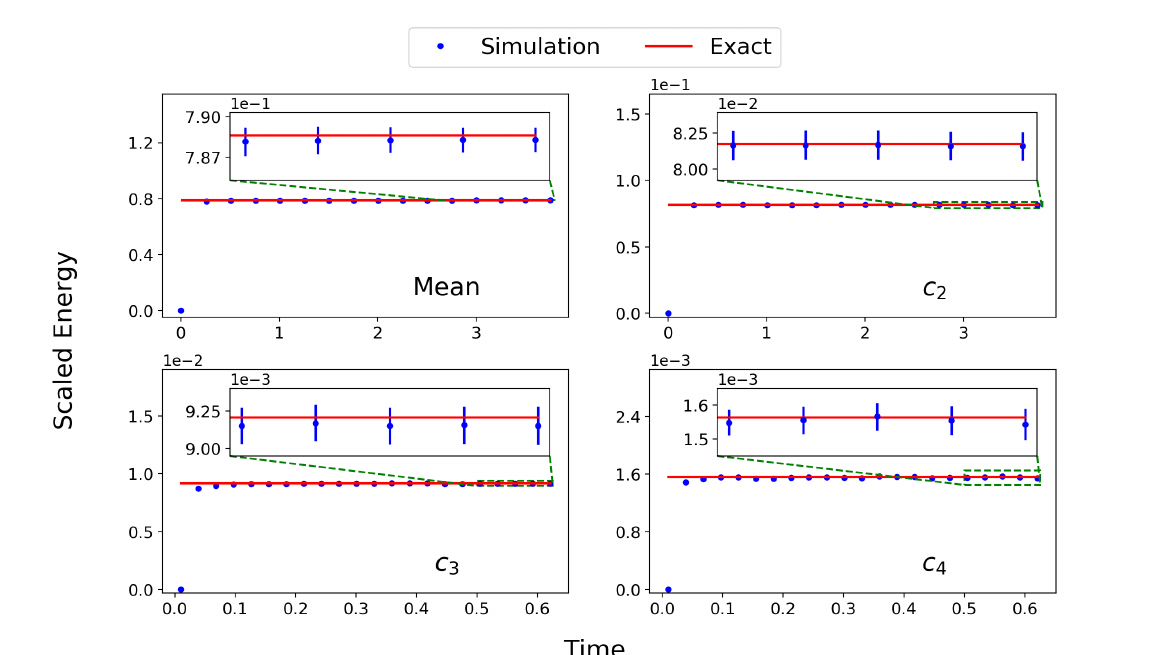
Figure 2: Insets highlight the agreement between theoretical predictions and Monte Carlo simulation of the first four energy flow cumulants in the hard rod gas. Theo- retical predictions from (25) are the red lines, Monte Carlo results are the blue dots with error bars. The initial velocities of the rods are drawn from normal distribu- tions, with mean 8 and variance 15, and mean − 3 and variance 10, for the left and right system halves, respectively. Other parameters are: rod length a = 0.56; 10 5 particles; 2 × 10 7 Monte Carlo samplings; initial system length 10 5 . Rod densities are fixed by the velocity variances in thermal distributions. The scaling parameter for the y -axis is ¯ v 3 / a where ¯ v is the average rod speed. Error bars are found